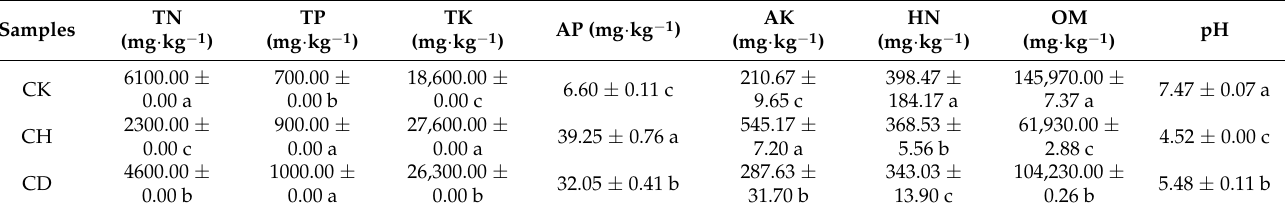
Table 3. Soil physicochemical properties of three soil samples.